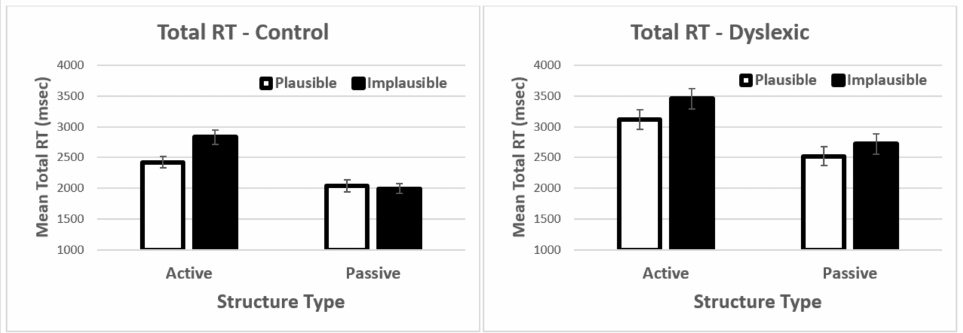
Figure 4. Mean total reading times. Error bars show the standard error of the mean.